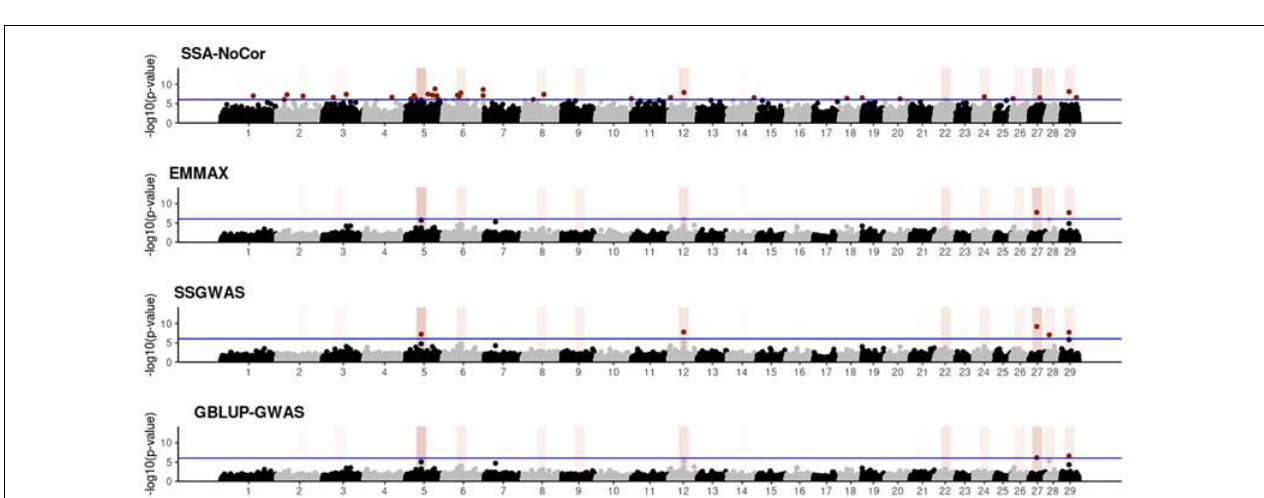
FIGURE 6 | Manhattan plots for the small population of beef cattle using single-SNP analysis without correction for population structure (SSA-NoCor), efficient mixed-model association expedited (EMMAX), single-step GWAS (ssGWAS), and genomic best linear unbiased prediction GWAS (GBLUP-GWAS). Significant SNPs are indicated in red, whereas vertical bars indicate the position of the simulated quantitative trait nucleotide (QTN). The darker the vertical bar, the stronger QTN effect. The blue horizontal line corresponds to the rejection threshold based on a significance level of 0.05 with a Bonferroni correction for multiple